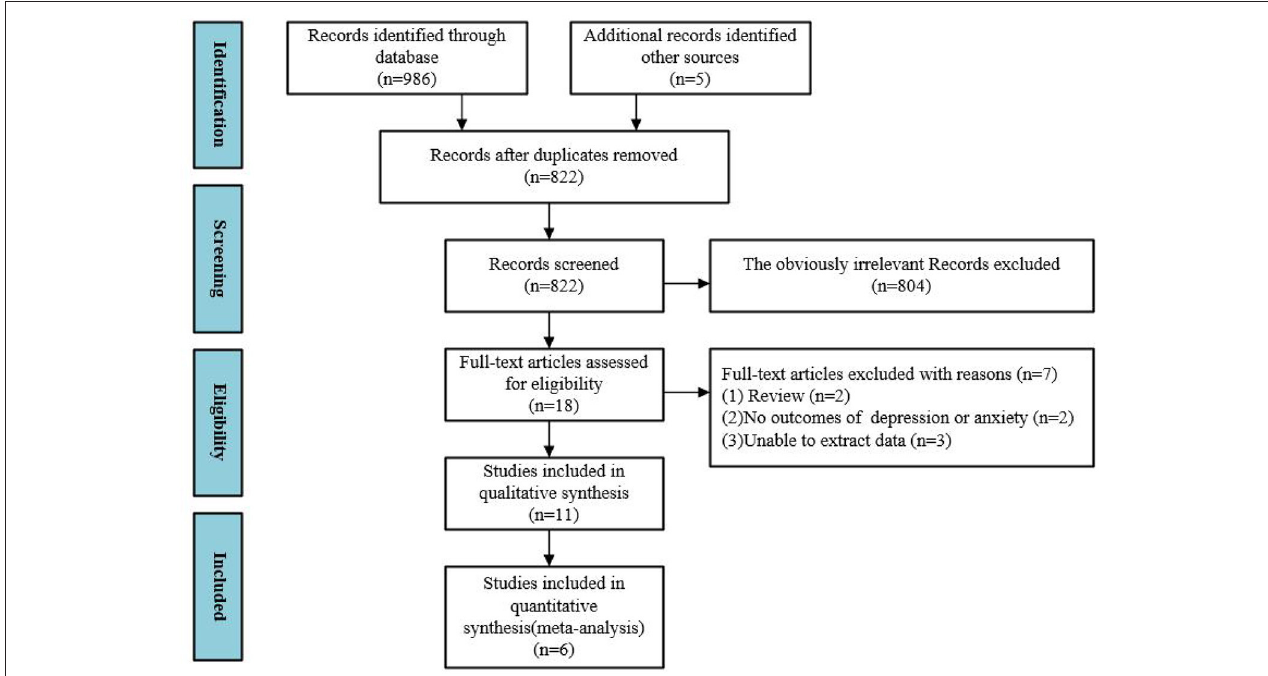
FIGURE 1 | The flow of literature search and study